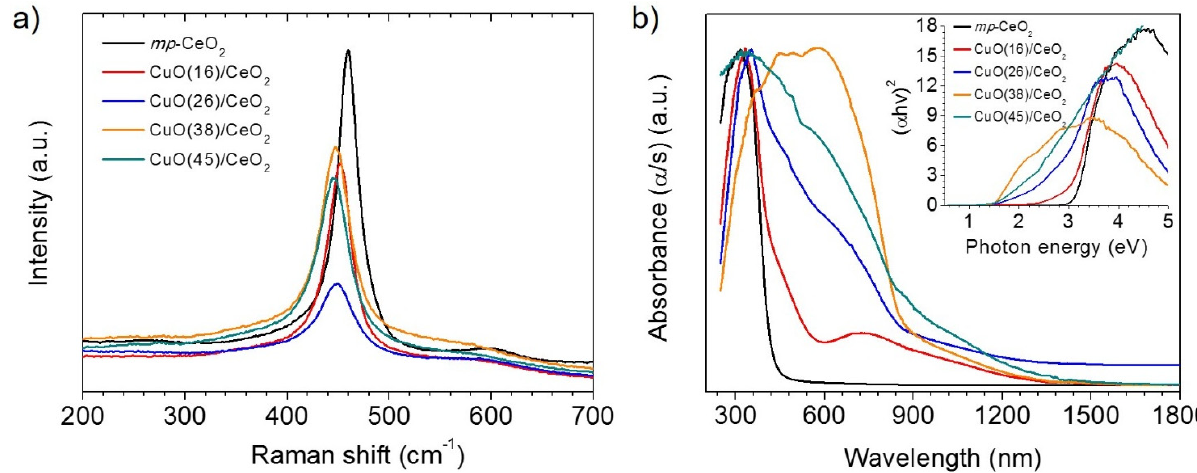
Figure 4. ( a ) Raman spectra and ( b ) ultraviolet-visible/near-IR (UV-Vis/NIR) diffuse reflectance spectra for mesoporous mp -CeO 2 and CuO/CeO 2 composite samples. Inset of ( b ) is the corresponding ( α hv ) 2 versus energy curves, where α is the absorption coefficient, h is Planck’s constant and v is the light